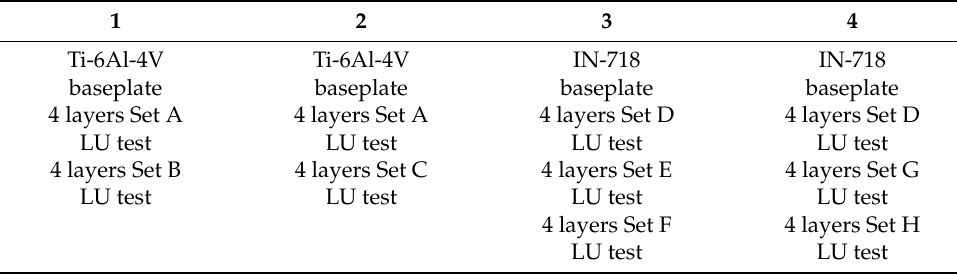
Table 2. DED-AM build sequence with laser ultrasound (LU)